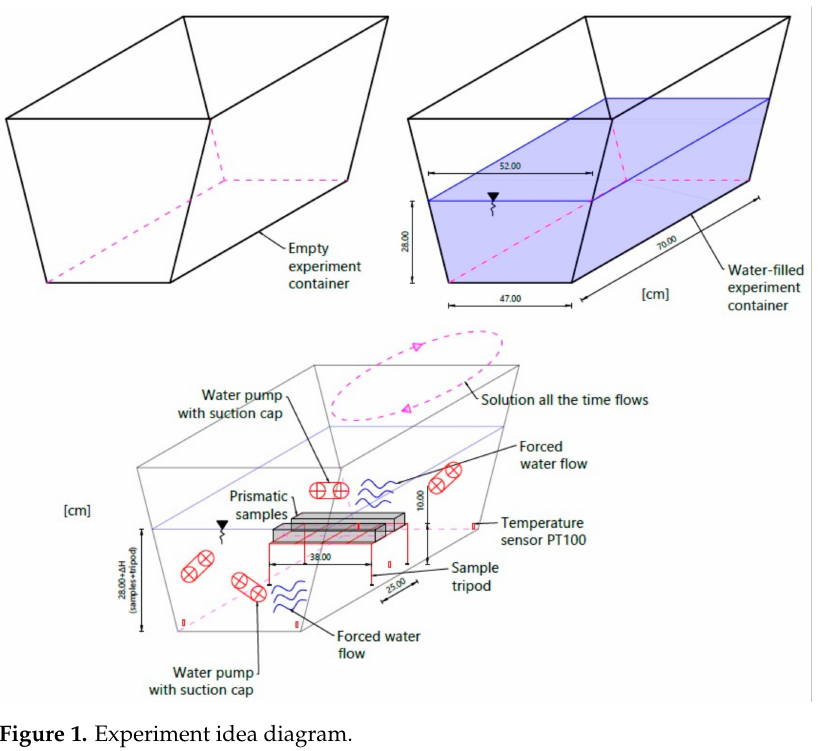
Figure 1. Experiment idea diagram.